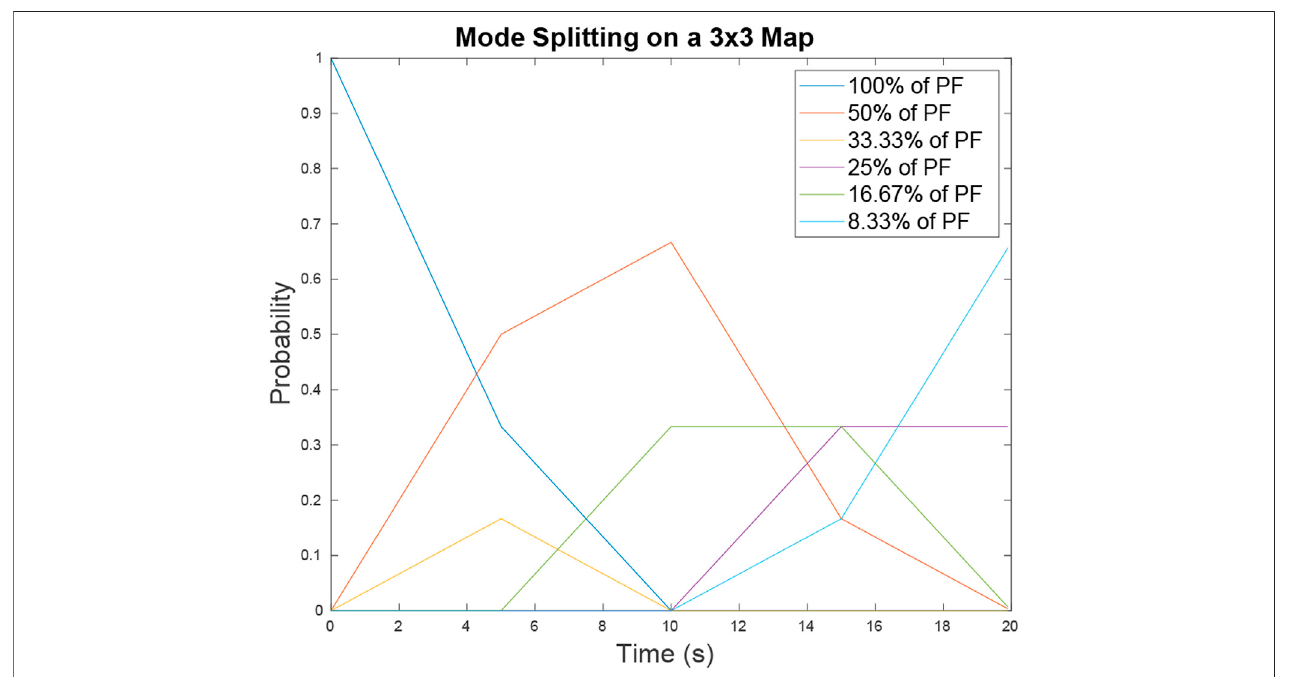
FIGURE8| Probabilityofmodeexistence P D formap6overtime t (cid:2) [0,20]s.Theprobabilityofamodethatcontains D percentoftheparticle fi lterisrepresentedby the different lines plotted. As time progresses the probabilities of larger modes decrease as they evolve into smaller modes with increasing likelihood.